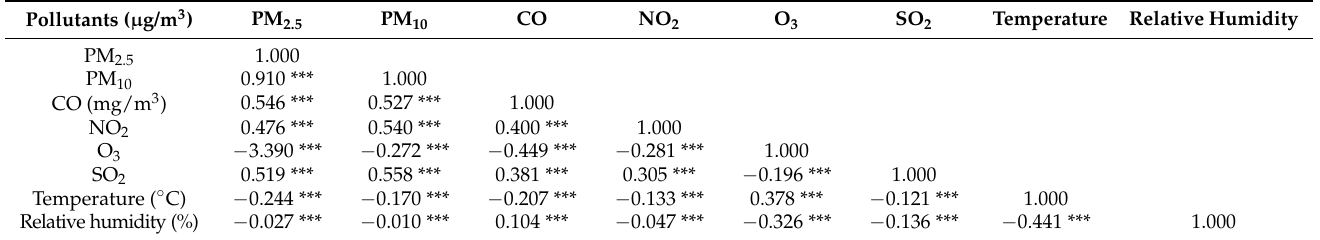
Table 3. Spearman correlation coefficients between ambient air pollutants and weather